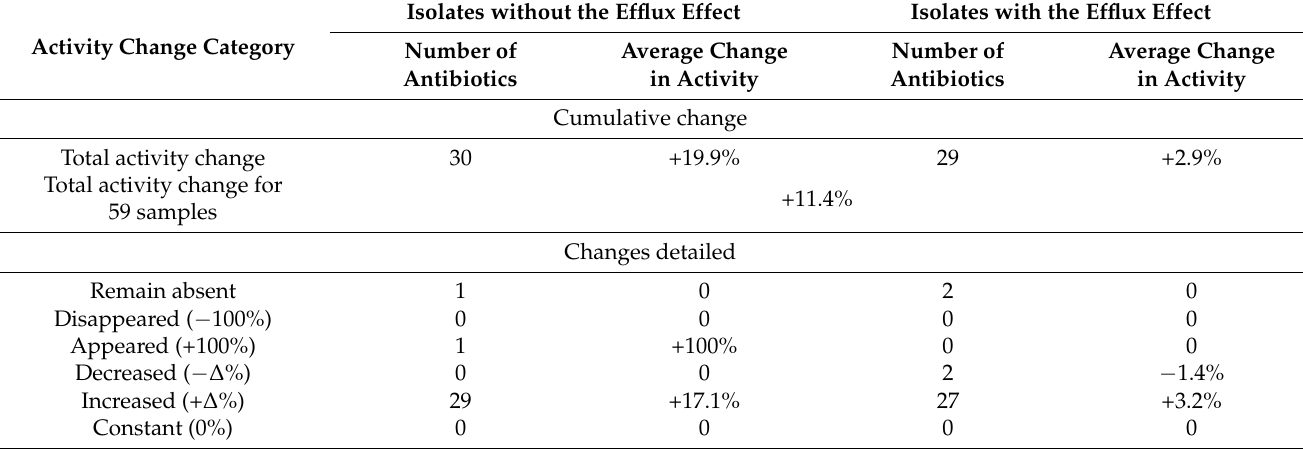
Figure 2. Activity of 31 antibiotics against S. aureus before (white columns) and after (red columns) cow treatment with Lactobay ( a , c ) and Argovit-C ( b , d ) for isolates with the efflux effect ( a , b ) and without the efflux effect ( c , d ). Table 3. Change in antibiotic activity towards S. aureus observed after treatment with Argovit-C for isolates with and without the efflux effect.